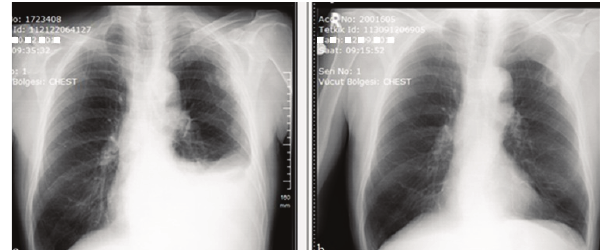
Figure 3: PET-CT demonstrating intense 18-FDG uptake by several thickened mediastinal and costal pleural areas, without the pre- sence of a salient primary lesion in the lung